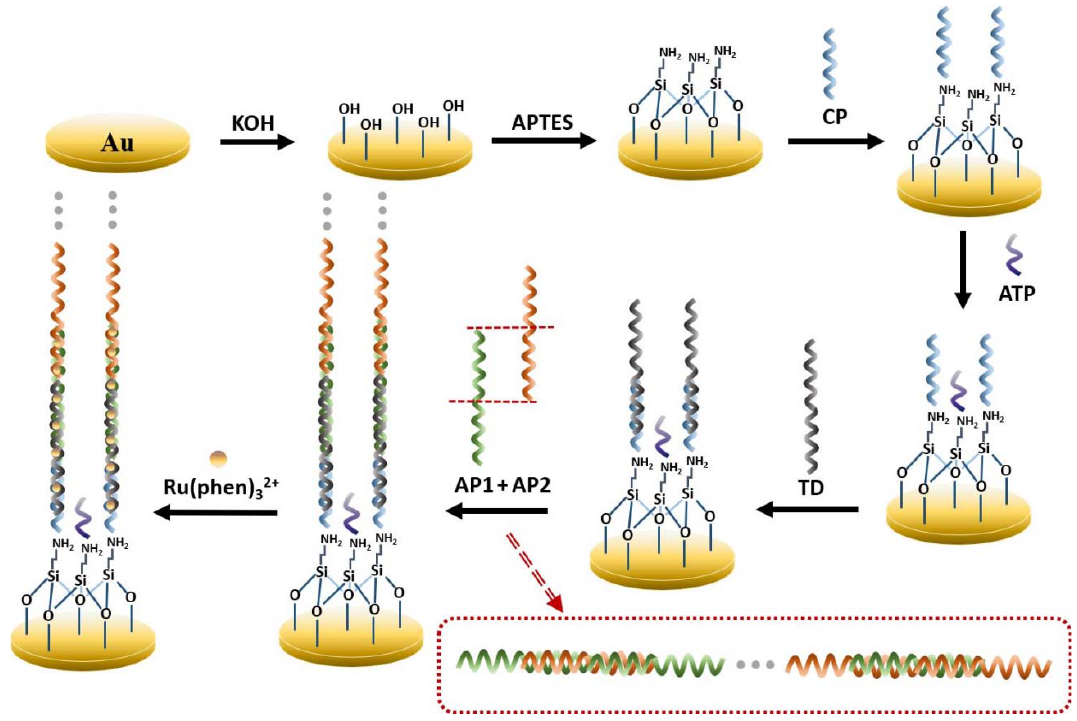
Figure 1. Schematic diagram of APTES ‐ modified super sandwich DNA ‐ based electrochemical biosensor.